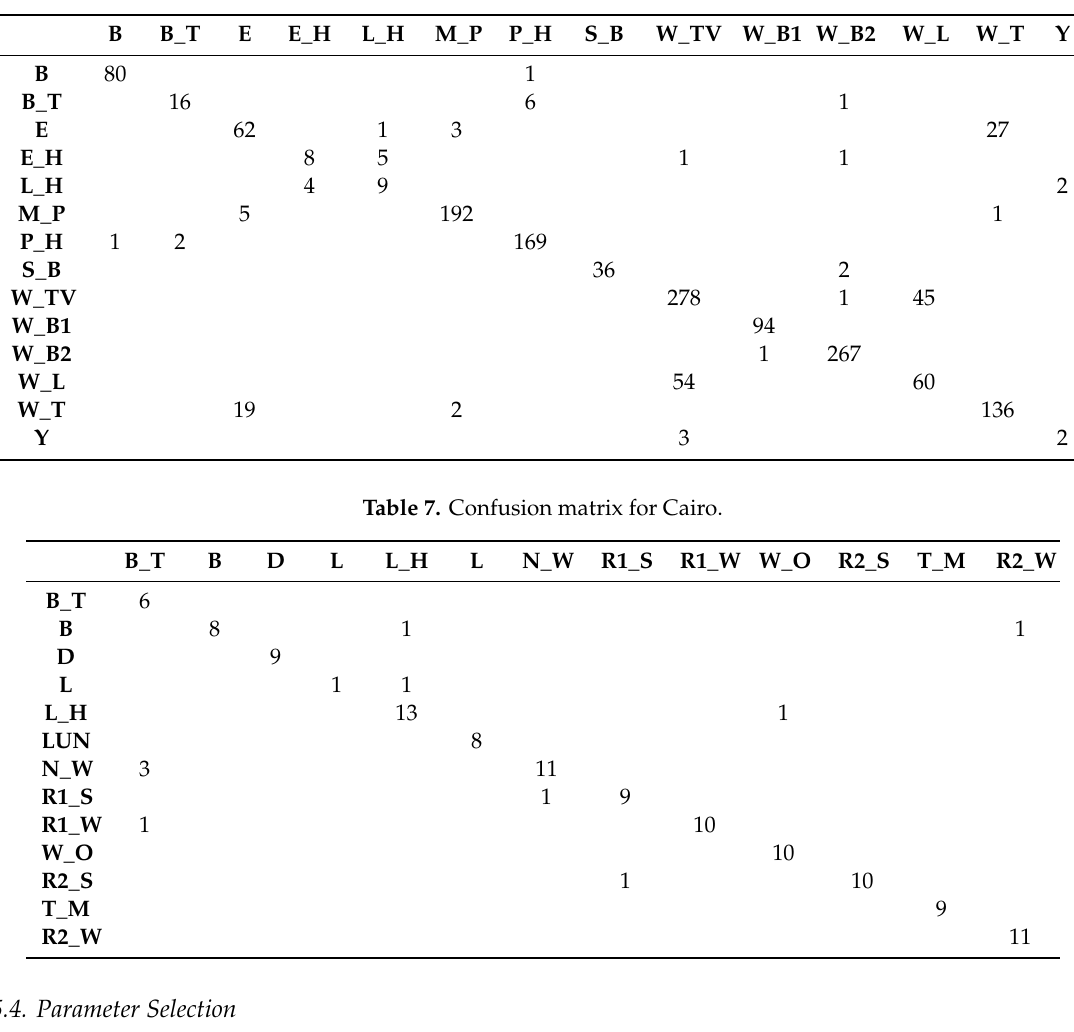
Table 6. Confusion matrix for Tulum2010.